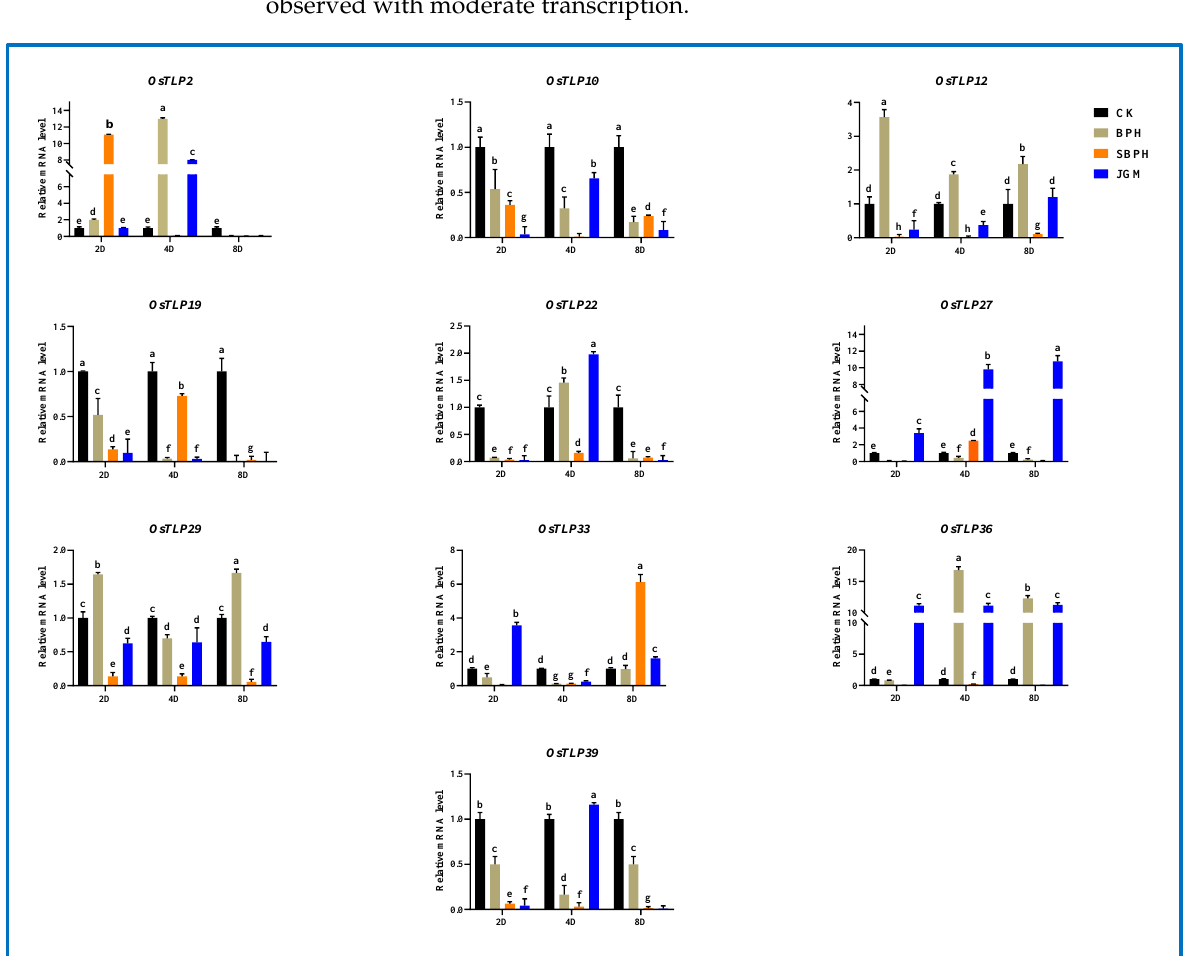
Figure 10. Differential expression analysis of OsTLP genes ( OsTLP2, OsTLP10, OsTLP12, OsTLP19, OsTLP22, OsTLP27, OsTLP29, OsTLP33, OsTLP36, and OsTLP39 ) under Nilaparvata lugens and Laodelphax striatellus infestations and Jinggangmycin (JGM) spraying treatment in Oryza sativa . Different letters indicate significant JGM is a synthetic antibiotic applied to treat rice sheath blight disease, and it is also